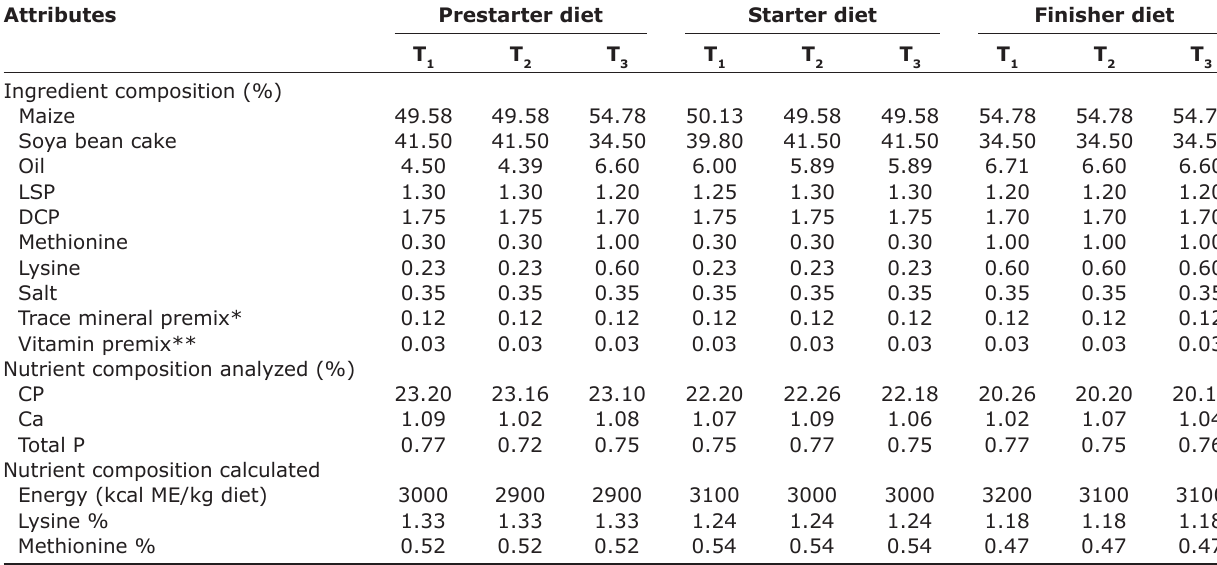
Table-1: Ingredients and nutrient composition of different broiler diets. Attributes